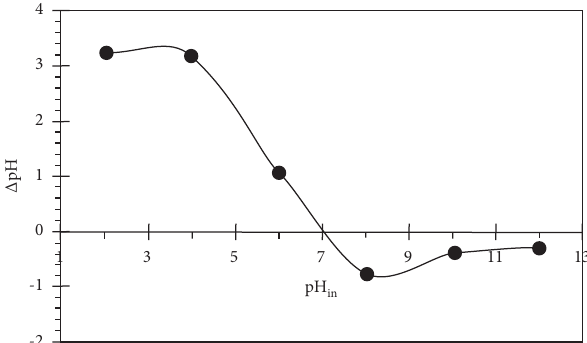
Figure 1: Plot of determination of point of zero charge of fish bone.